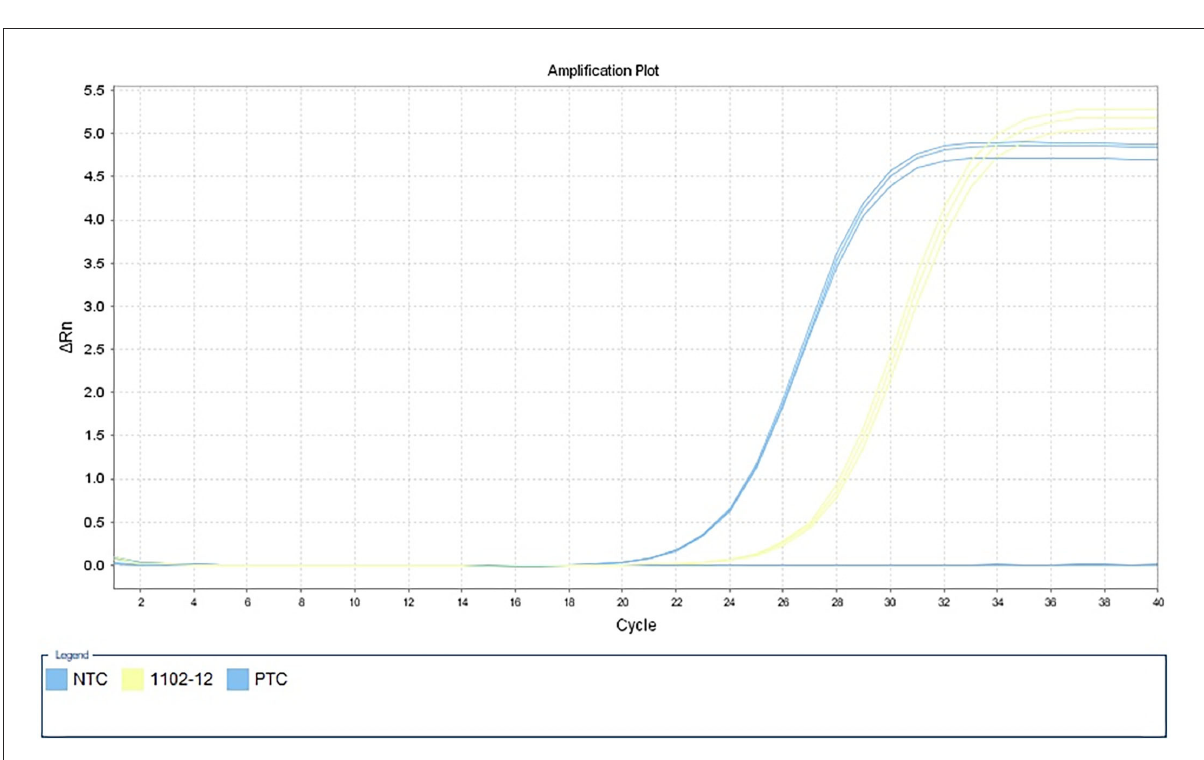
FIGURE3 Detection of Klebsiella pneumoniae by qPCR in alveolar lavage fluid samples. NTC, negative control; 1102–12, alveolar lavage fluid sample; PTC, positive control.